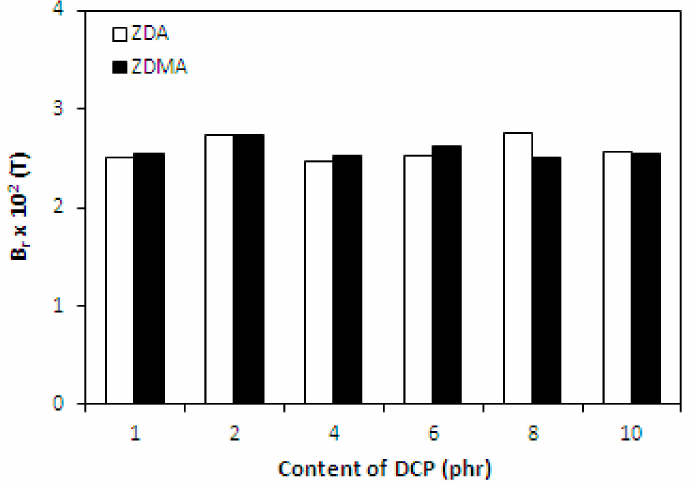
Figure 19. Influence of peroxide content on remanent magnetic induction B r of